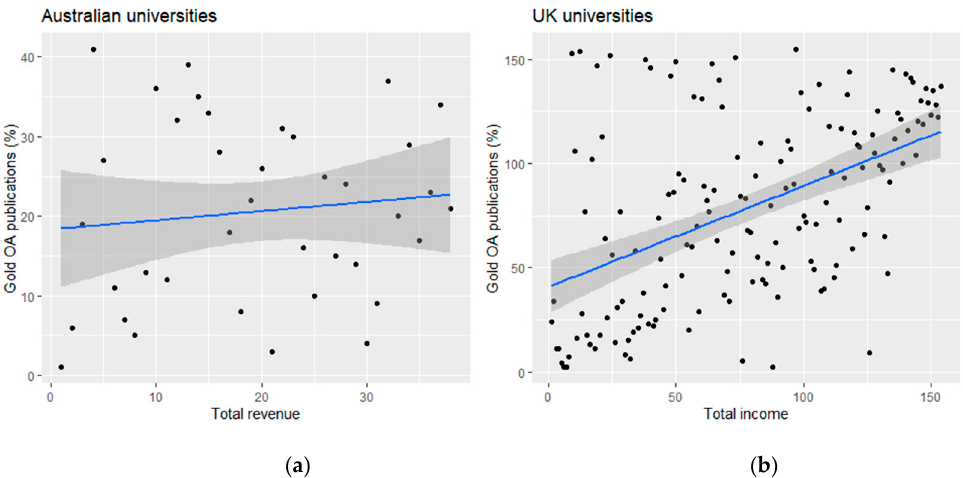
Figure A1. Scatterplot shows correlations between percentages of Gold OA publications and reve- nue or income across ( a ) 41 Australian and ( b ) 155 United Kingdom universities, 2020. The data